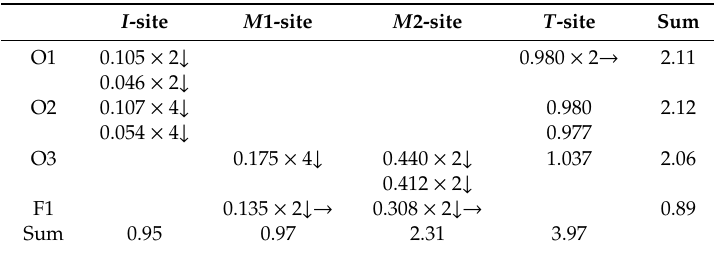
Table 7. Bond-valence (vu) analysis for fluorluanshiweiite.